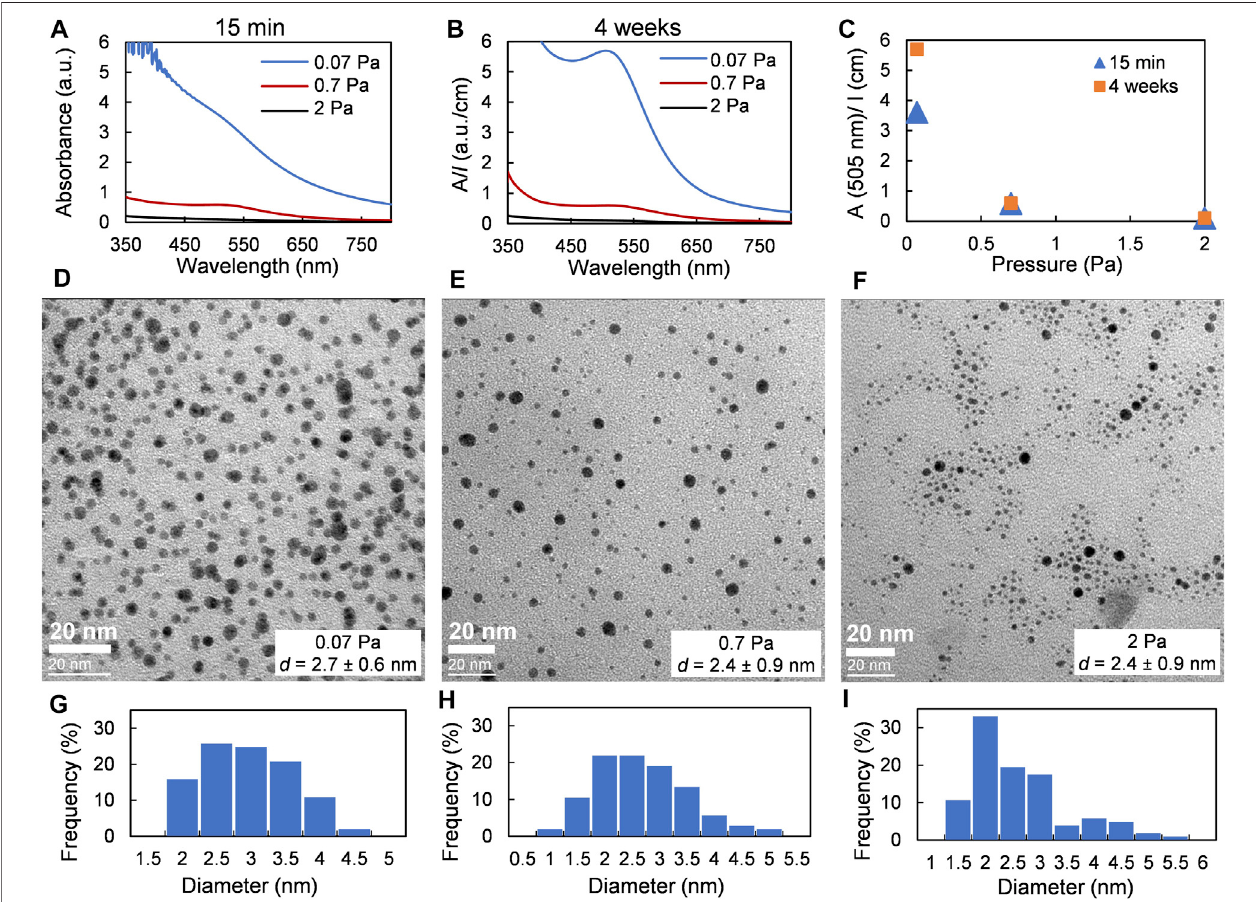
FIGURE 4 | | Effect of argon pressure. Samples were obtained at a fi xed applied power of 80 W and a sputter time of 10 min. (A) and (B) UV-vis spectra of dispersionsofAuNPsincastoroilrecorded15minand4weeksafterdeposition,respectively (C) ChangesinabsorbanceatthemaximumofSPRbandofAuNPs. (D – F) TEM images and (G – I) size distributions of Au NPs obtained at argon pressure of 0.07, 0.7, and 2 Pa, respectively.